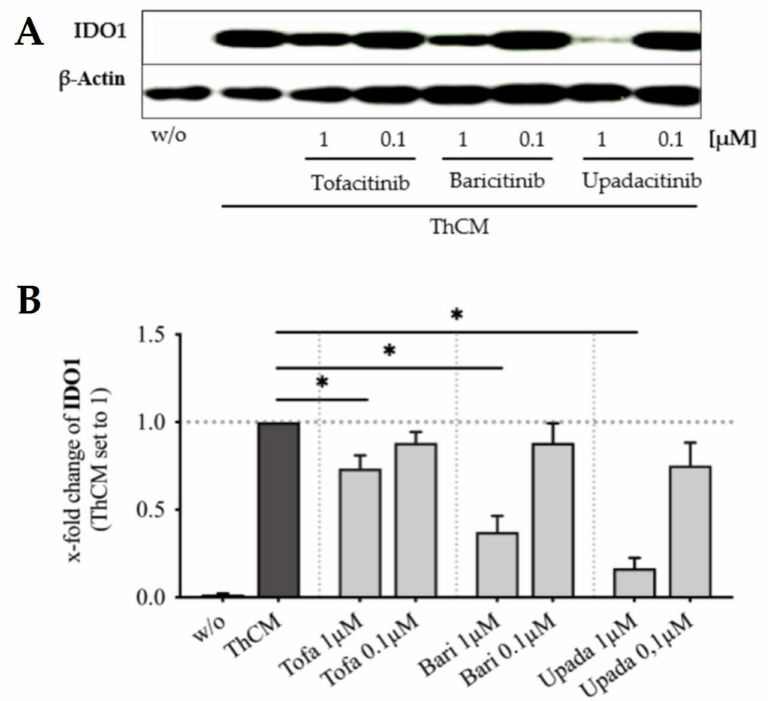
Figure 8. Effects of tofacitinib, baricitinib and upadacitinib on the expression of IDO1 by SF stimulated with ThCM. OASF or RASF were left untreated (w/o) or stimulated with ThCM and treated with tofacitinib ( n = 7), baricitinib ( n = 7) or upadacitinib ( n = 5). On day 4, SF were harvested and whole cell extracts were subjected to immunoblot analysis. Shown are the results from one representative experiment ( A ) and the x-fold change of indoleamine 2,3-dioxygenase 1 (IDO1) relative to b-actin expression with SF stimulated with ThCM set as 1 detected in all experiments ( B ). Data shown as mean ± SEM, significance tested using Wilcoxon signed-rank test, p * ≤